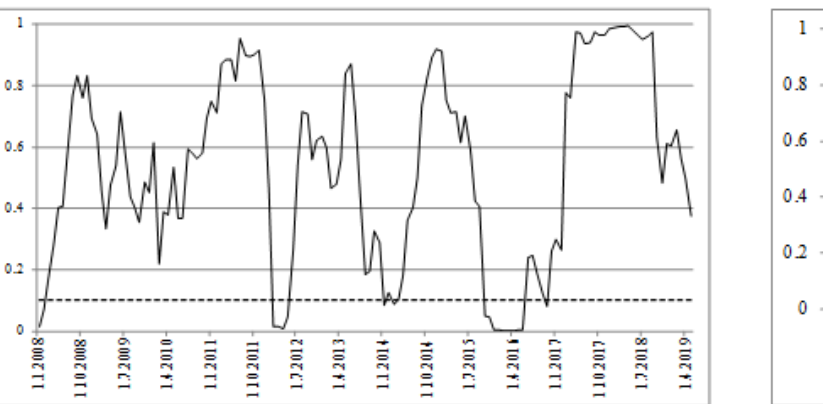
Figure A5. Rolling correlations between return ‐ EPU series and risk ‐ EPU series ( left axis ) compared to rolling total spillover indices ( right axis ).